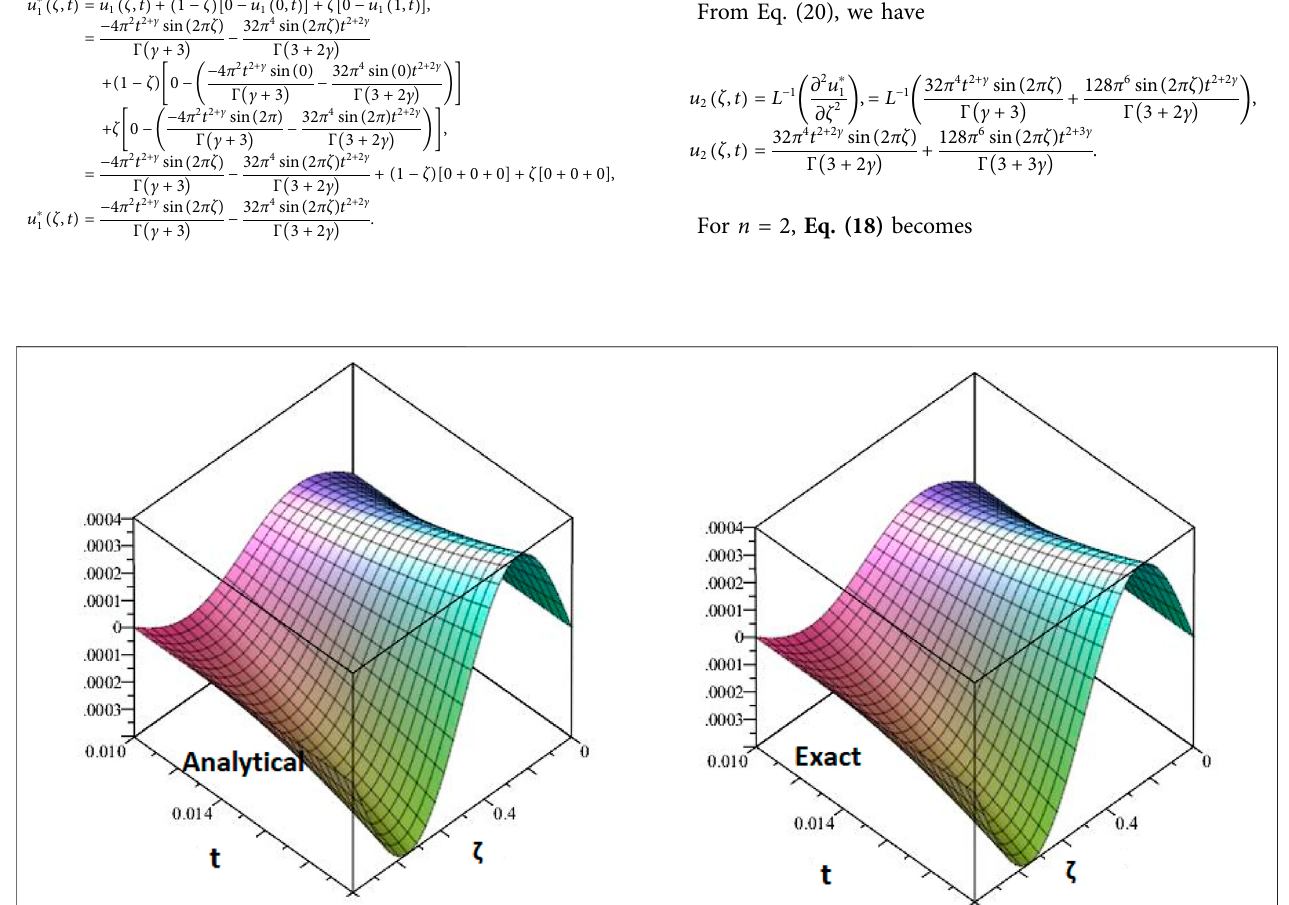
FIGURE 14 | 2D plots for the exact and analytical solution at γ =1 for Example 4